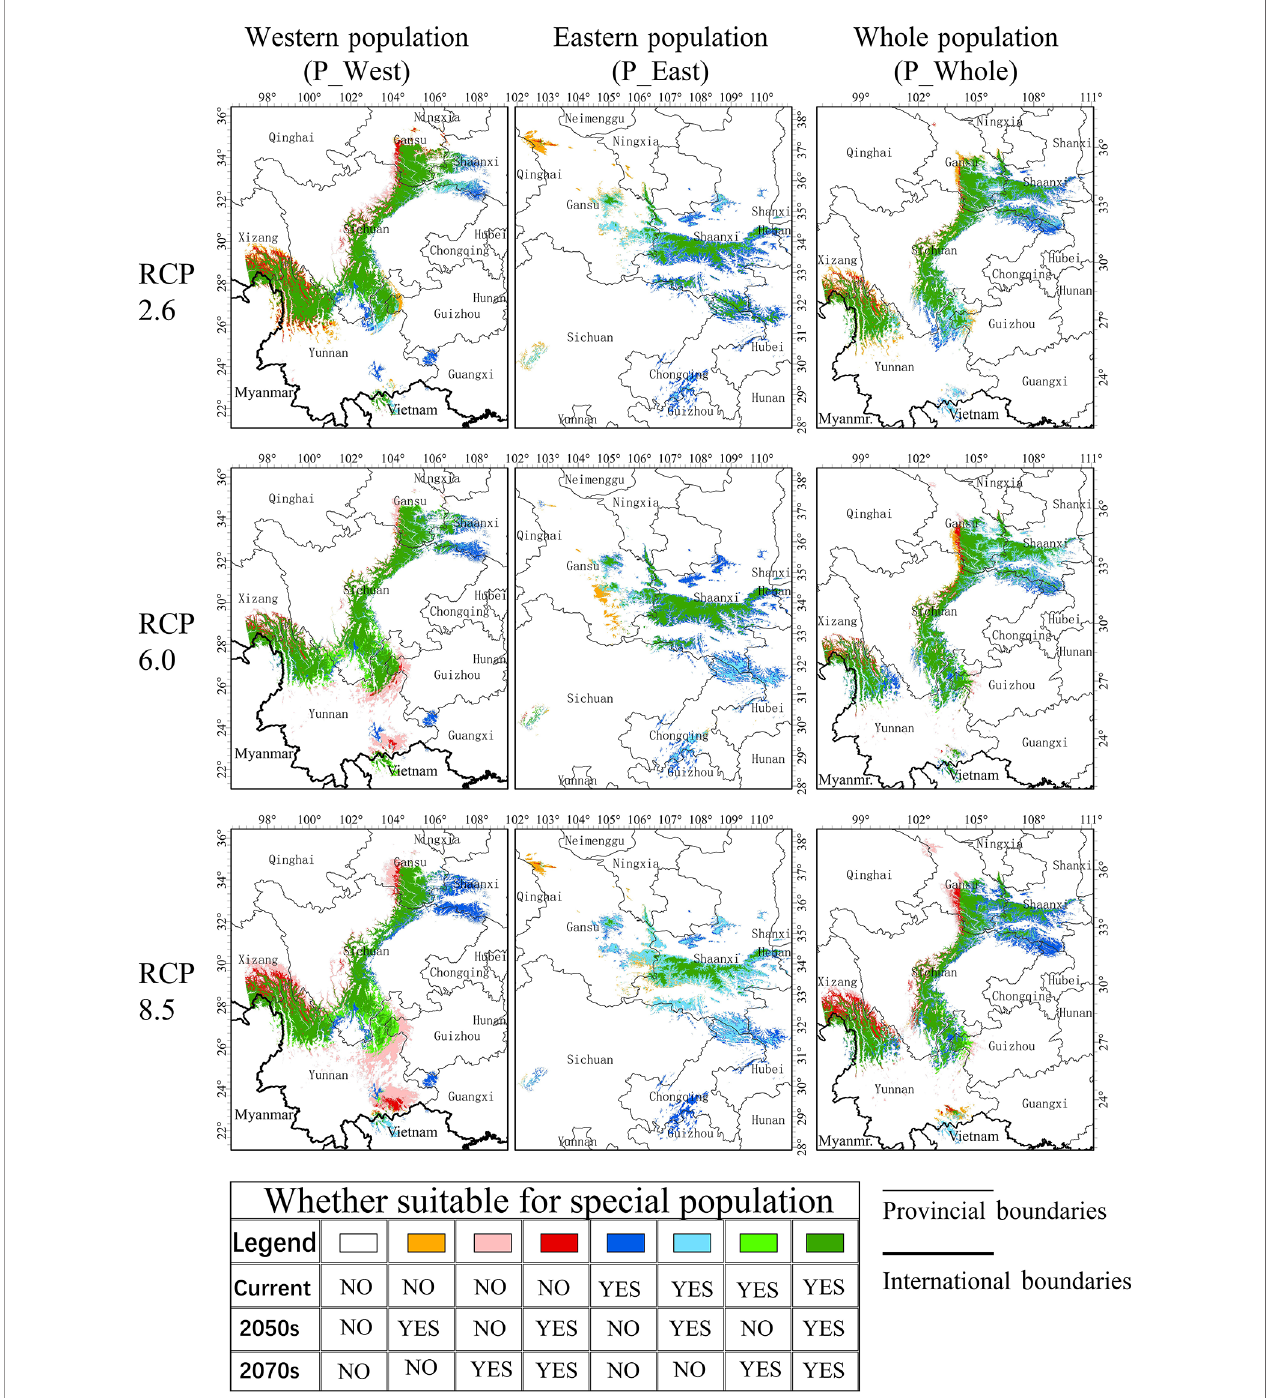
FIGURE 7 | Changes to suitable areas under climate change. Eight colors refer to eight situations that occurred in speci fi c locations. Green or grass green refer to a relatively stable region that is suitable for P. mairei ; blue or sky blue refer to a threatened region where it will no longer become suitable from the 2050s or 2070s; red or pink refer to a promising region where conditions will become suitable from an unsuitable state from the 2050s or